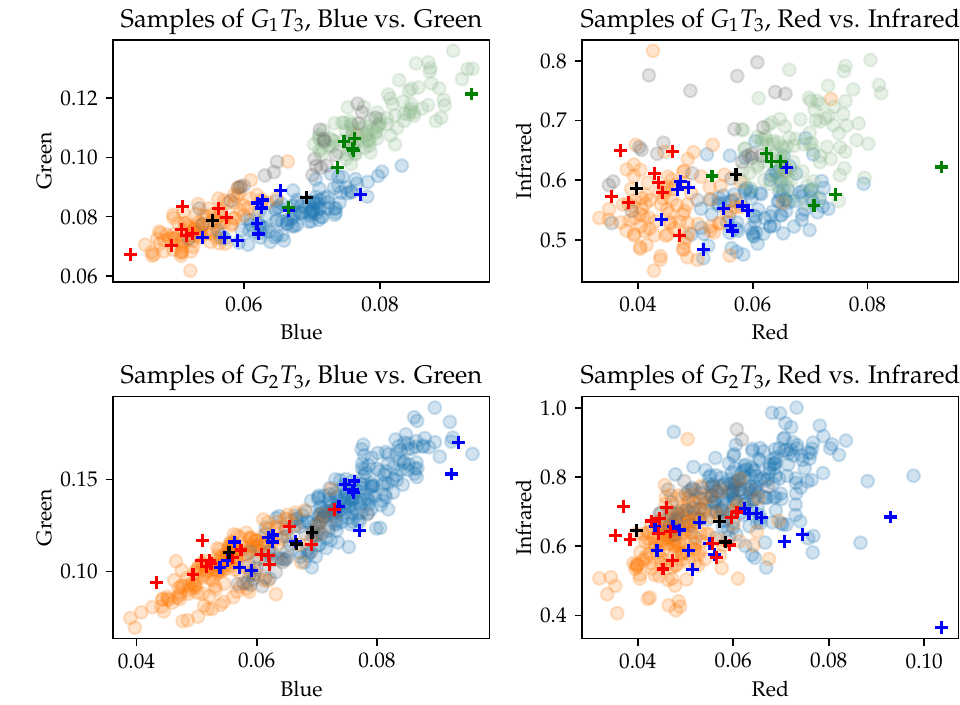
Figure 3. Scatter plots of the samples of the dependent ( ◦ ) and independent ( + ) test data in blue vs. green and red vs. infrared. Colors are used as follows: grey : Rumex obtusifolius plants, blue : Lolium perenne -community, red : Alopecurus pratensis -community, green : Bromus Hordeaceus